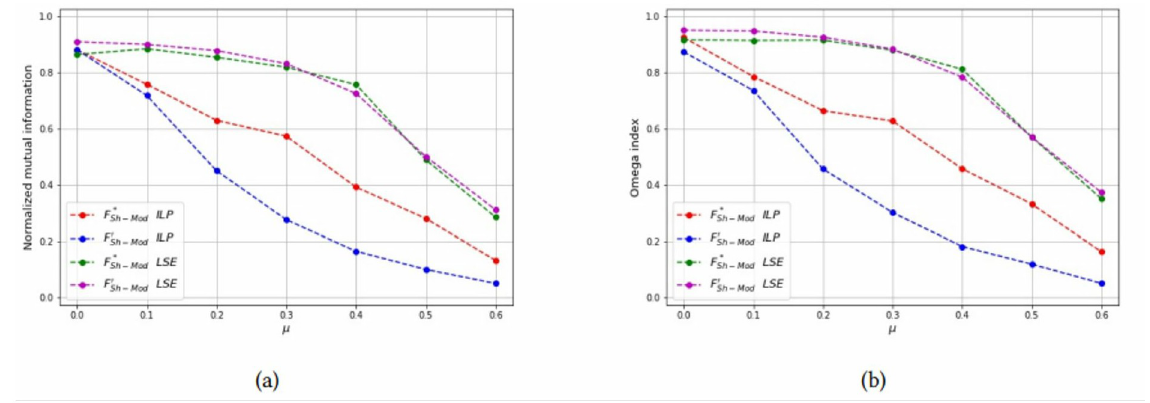
Fig 15. Test results on overlapping communities, parameters p = 2, μ o = 0.5, N o = 1. (a) Average NMI for each solution method, (b) Average Omega for each solution method.